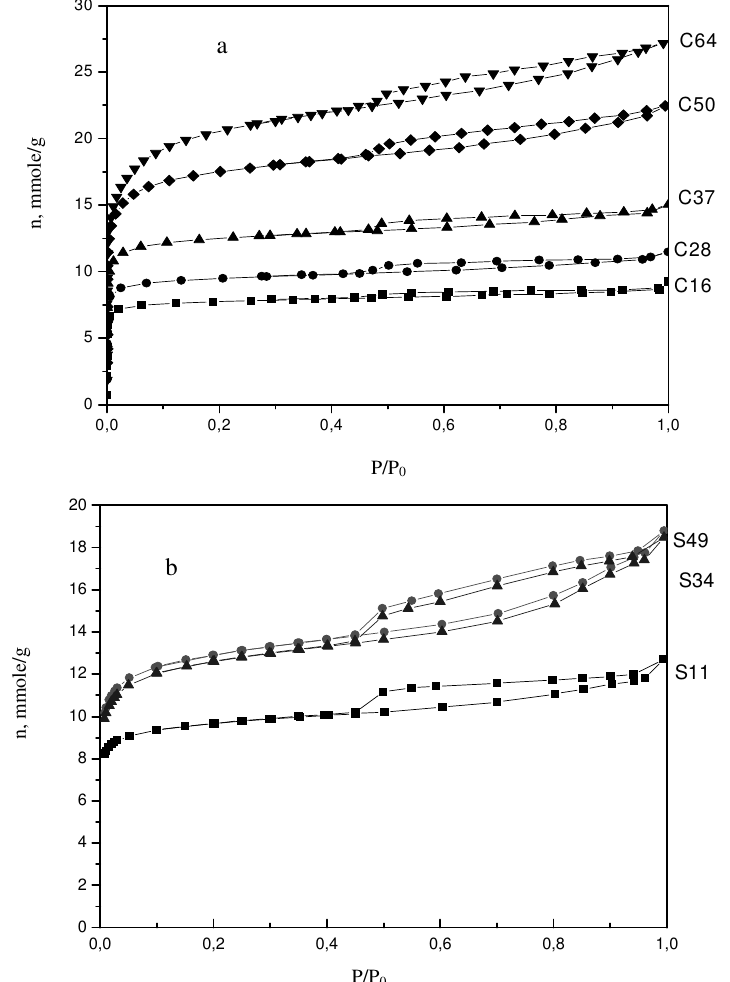
Figure 1. N adsorption desorption isotherms at 77 K for activated carbons with increasing 2 burn-off (a) samples activated with CO and (b) samples activated with 2